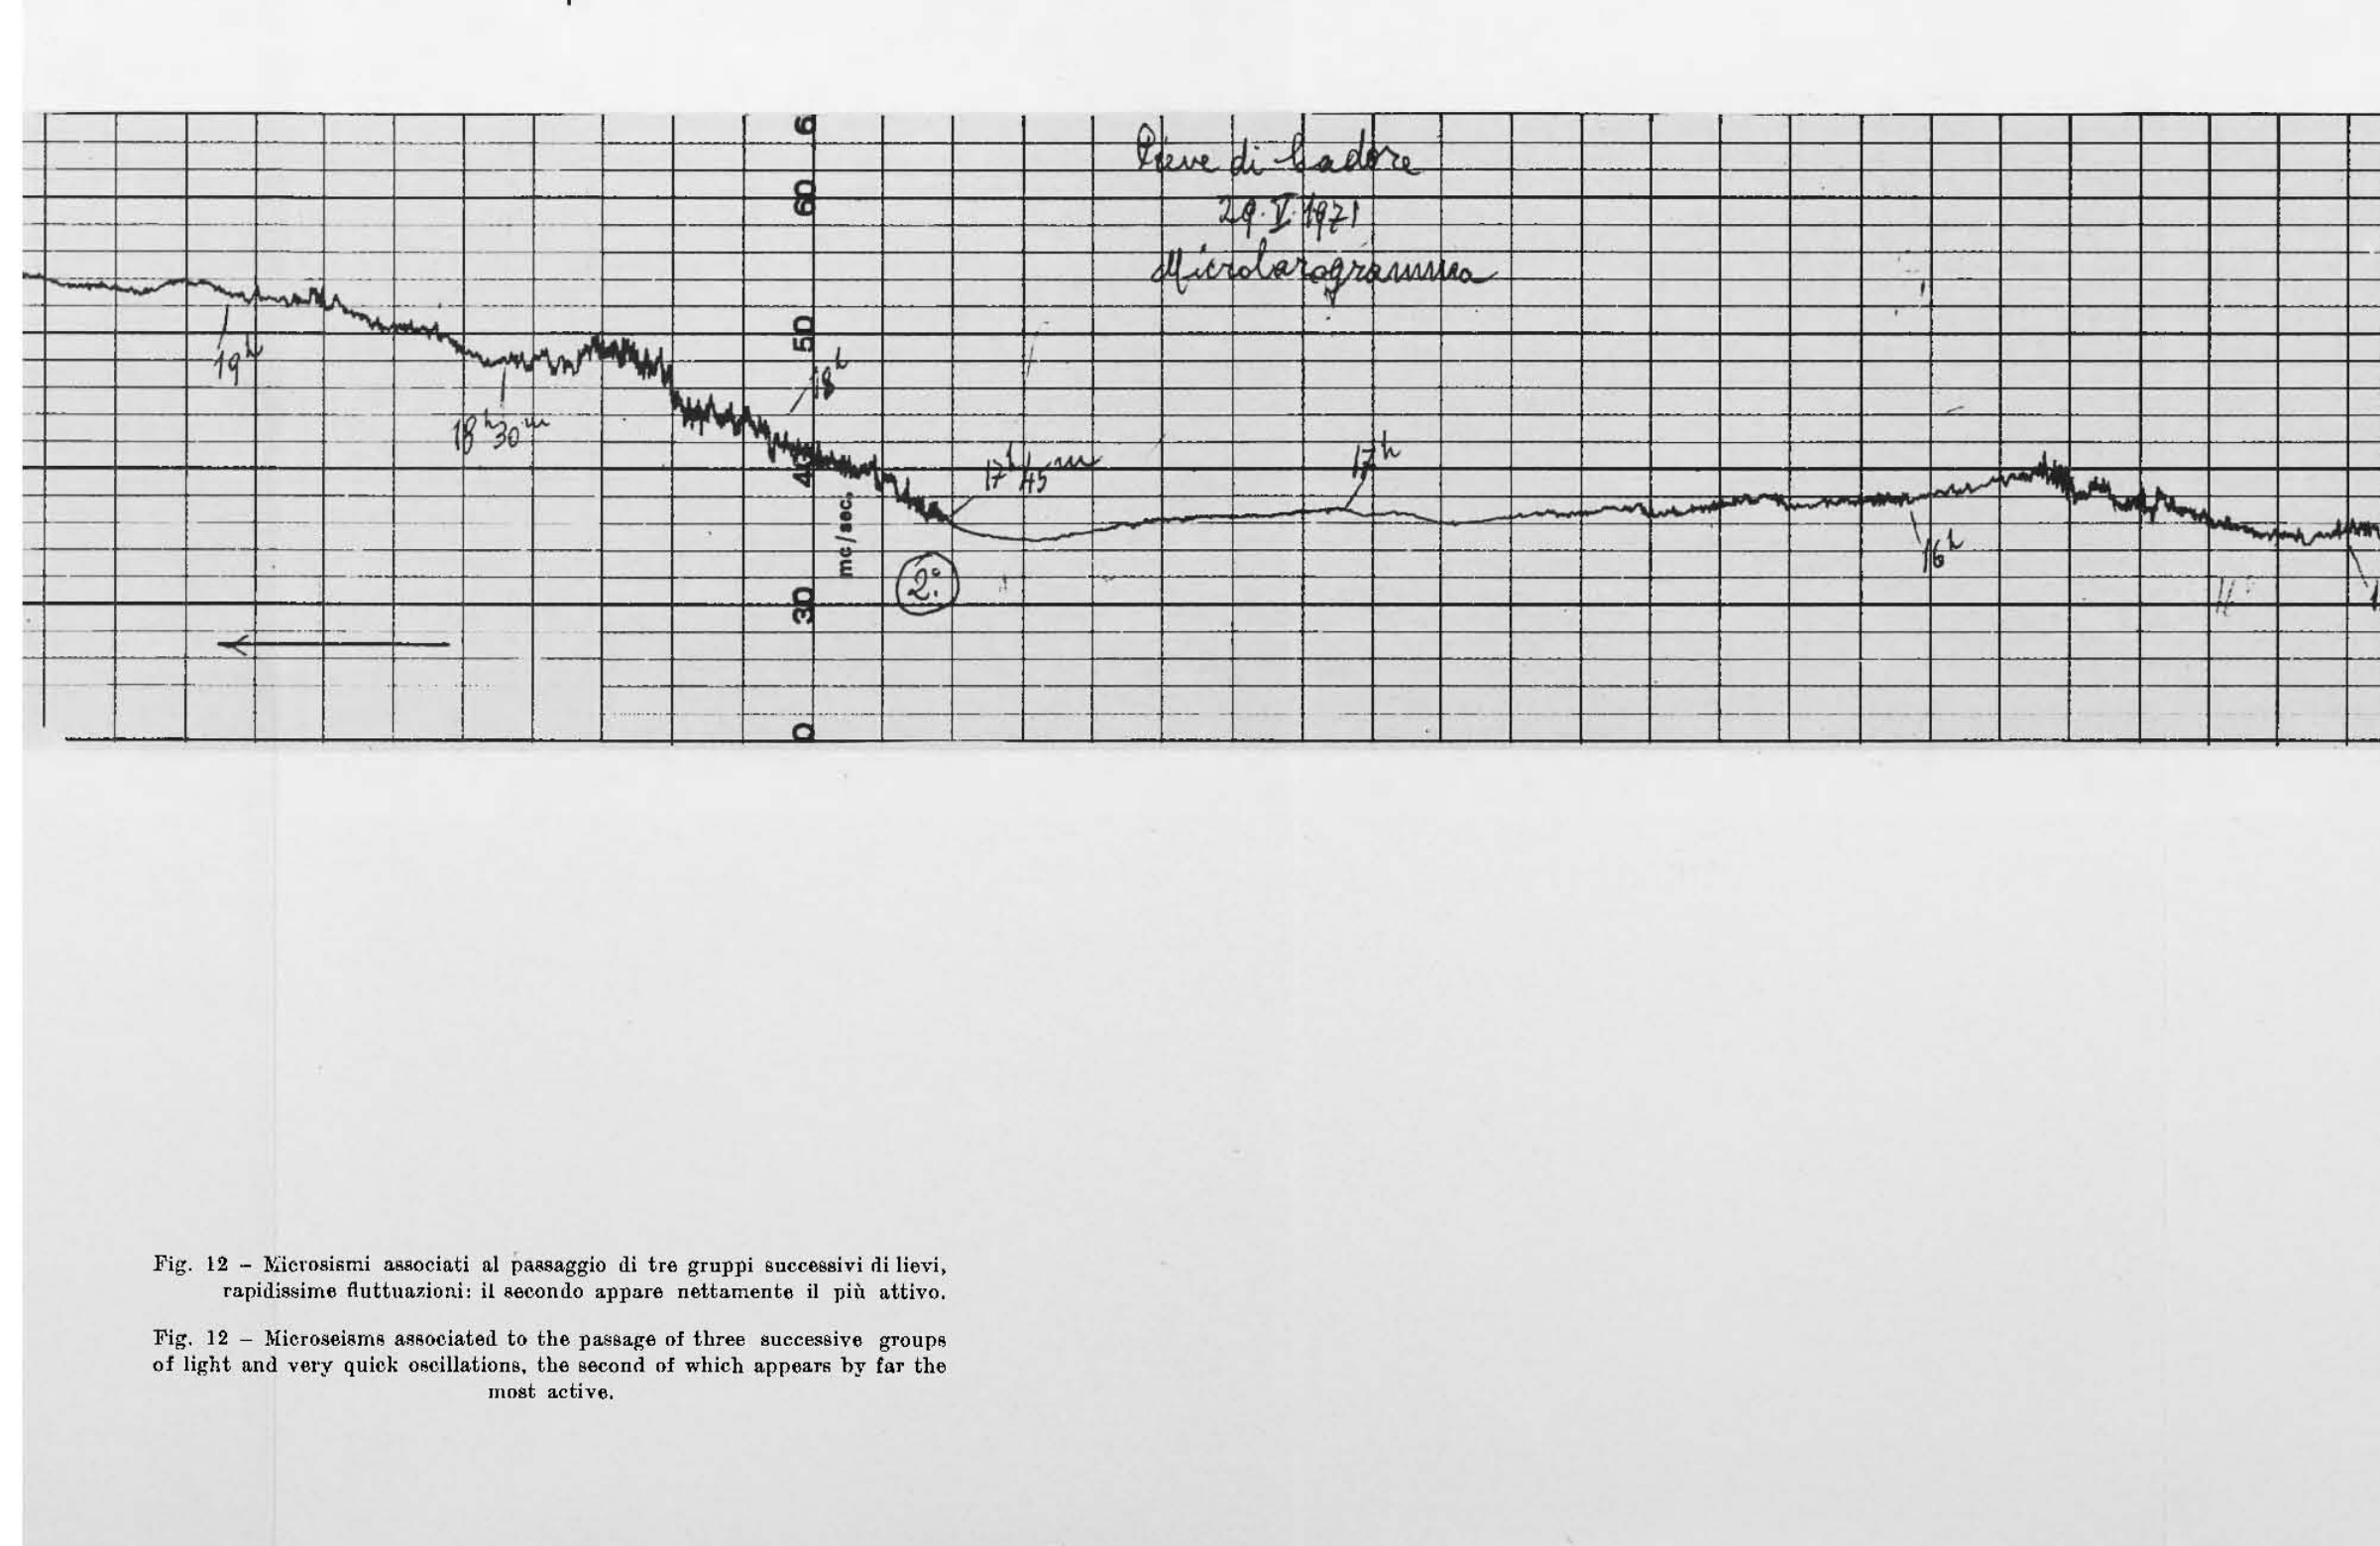
Fig. 12 - ?~icrosismi fl.Bsociati al passaggio di tre gruppi successivi Ili lievi, rapidissime fluttuallioni: il secondo appare nettamente il più. attivo. Fig. 12 - Microseisms associated to the passage of three successive groups of light and very quick oscillations, the second of which appears by far the 1Il0st